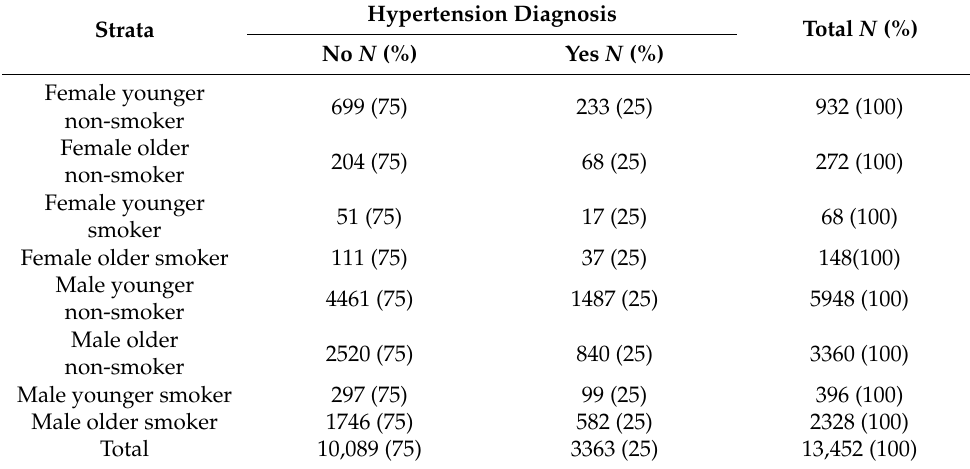
Table A1. Age-, sex- and smoking-matched strata according to hypertension (likelihood ratio: p =